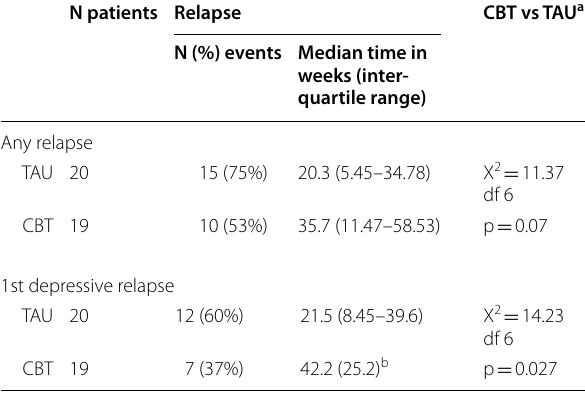
a Co-variates are listed in methods b Full inter-quartile range cannot be shown as < 50% CBT cases experienced a depressive relapse